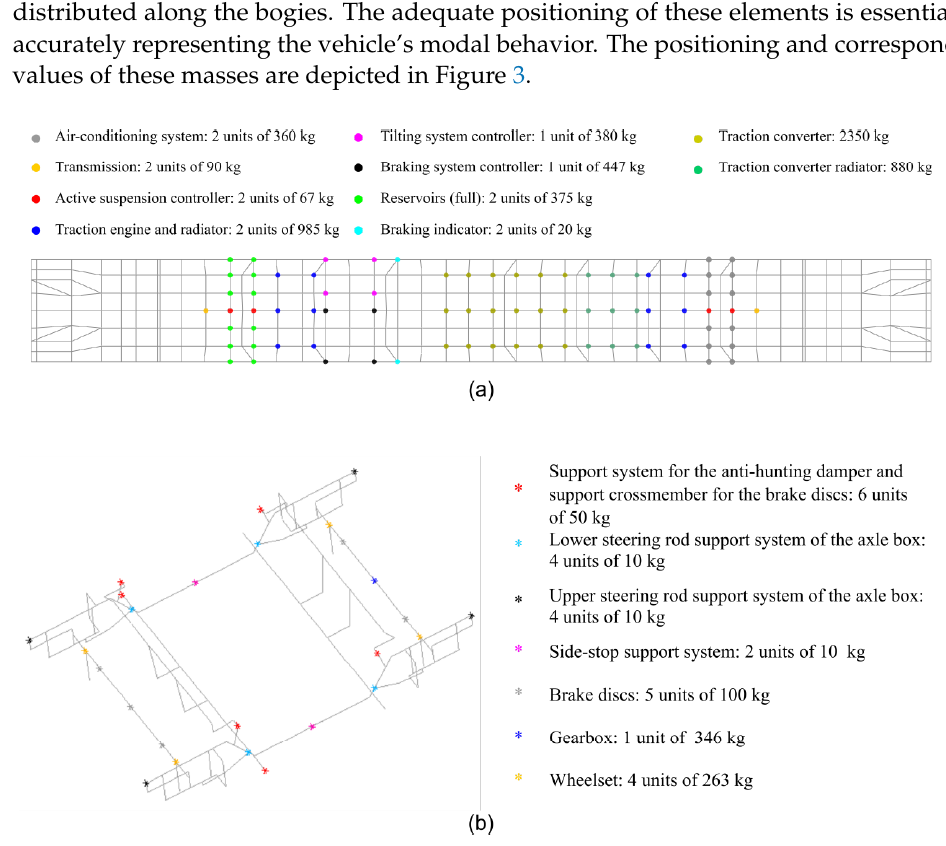
Figure 3. Mass elements in the finite element model: ( a ) carbody; ( b ) bogie.